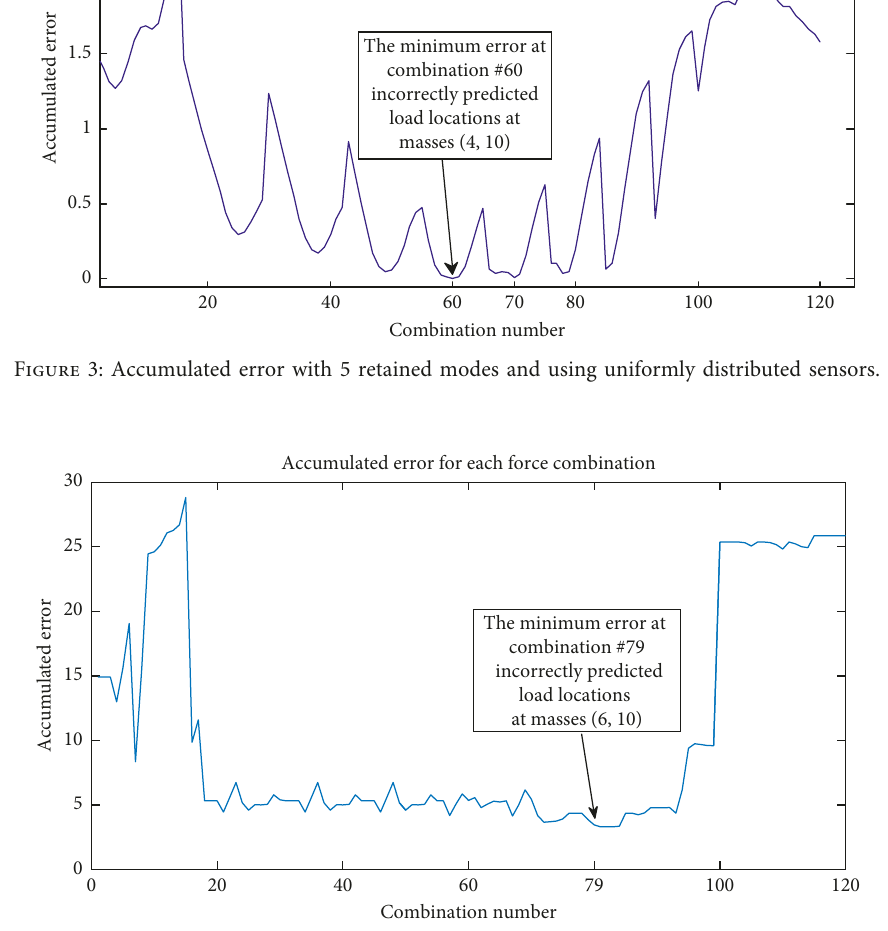
Figure 4: Accumulated error with 15 retained modes and 5 uniformly distributed